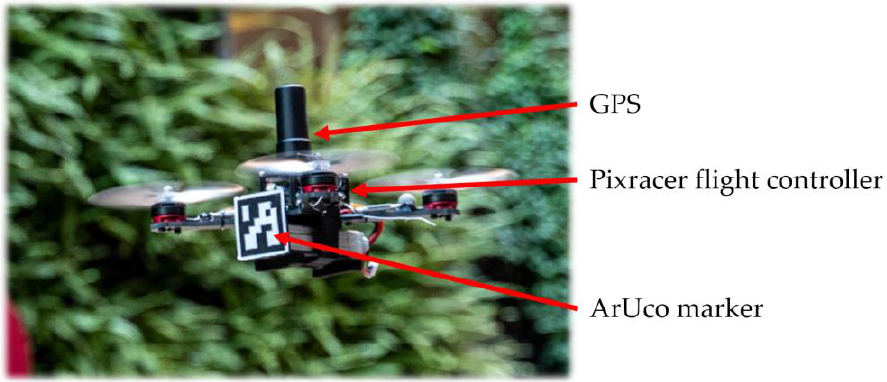
Figure 7. The hardware setup of the quadrotor UAV.